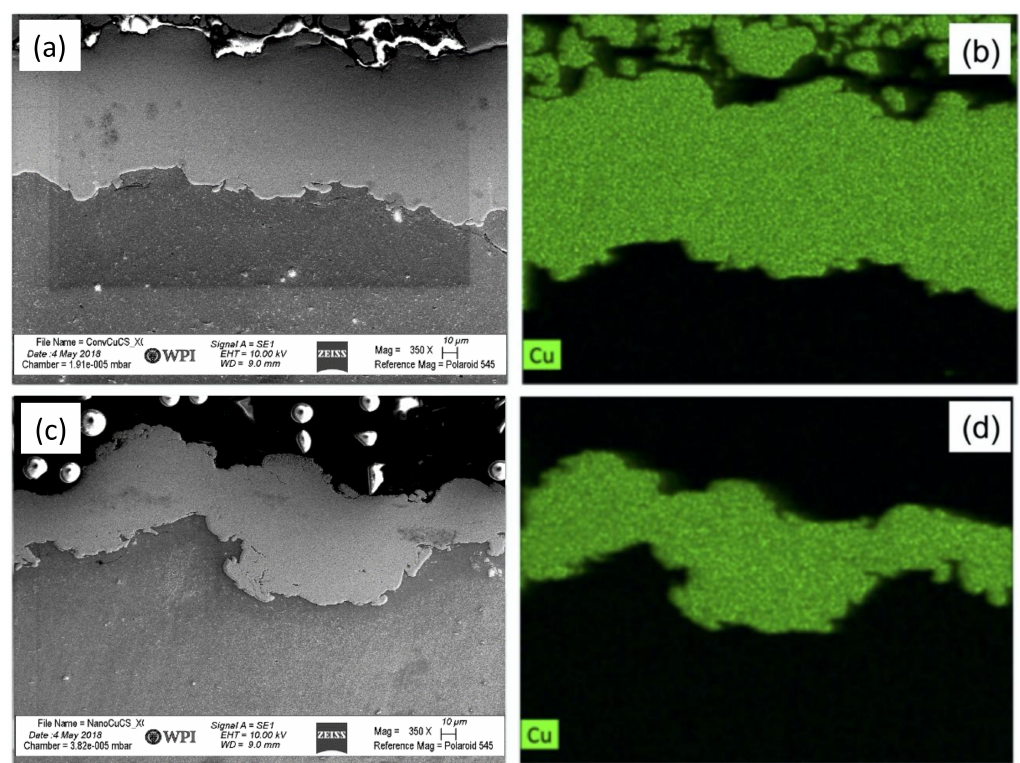
Figure 17. EDS of a consolidated cross-sectional orientation of the conventional Cu coating as shown in ( a ) and ( b ). EDS of a cross-sectional orientation of the nanostructured Cu coating as shown in ( c ) and ( d ).